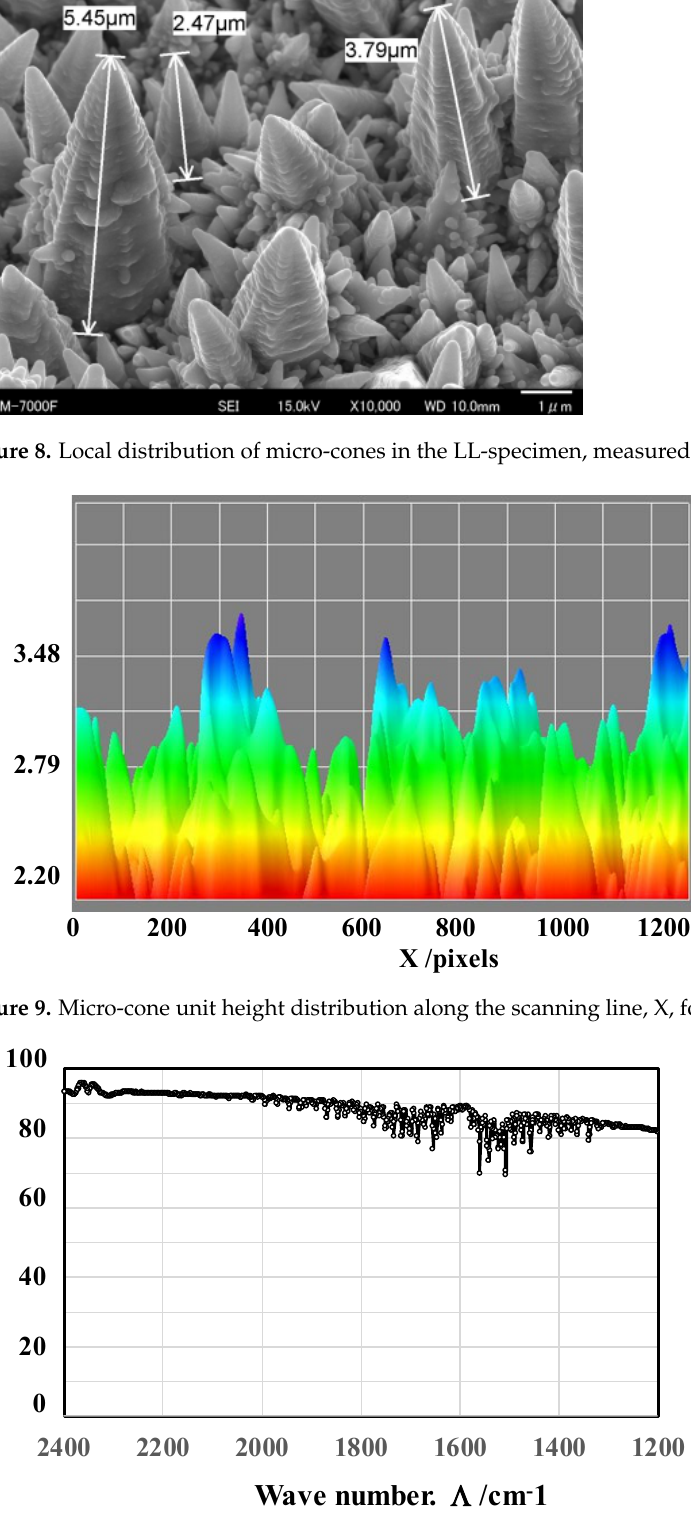
Figure 10. The transmittance spectrum measured by FT-IR in the range of wave number from 2400 cm −1 to 1200 cm −1 or in the range of wavelength from 4.2 μm to 8.4 μm for the LL-specimen.